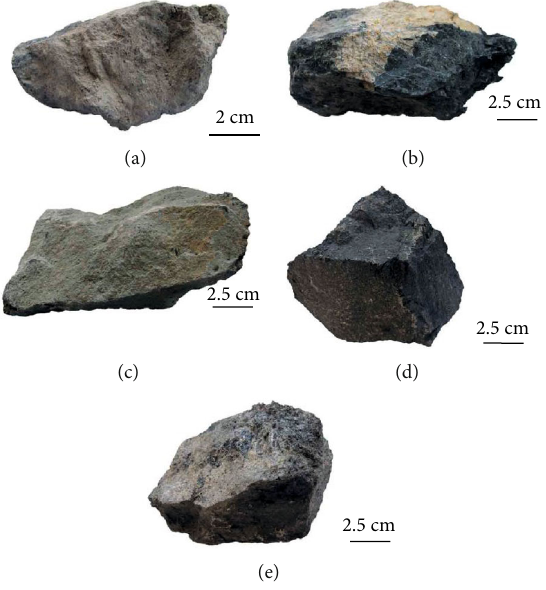
Figure 3: Photo of the igneous rock samples. (a) TS2. (b) TS6 (coal and rock mixed). (c) TS5. (d) TS3. (e)